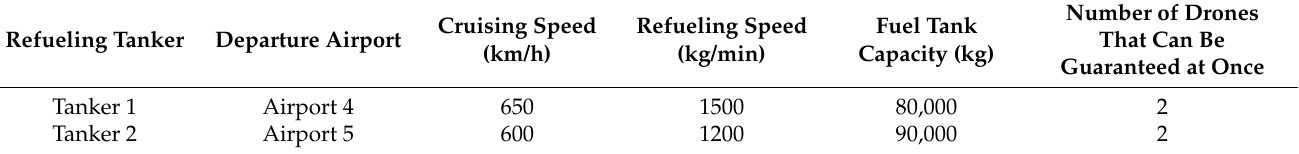
Table 3. Refueling tanker parameters.